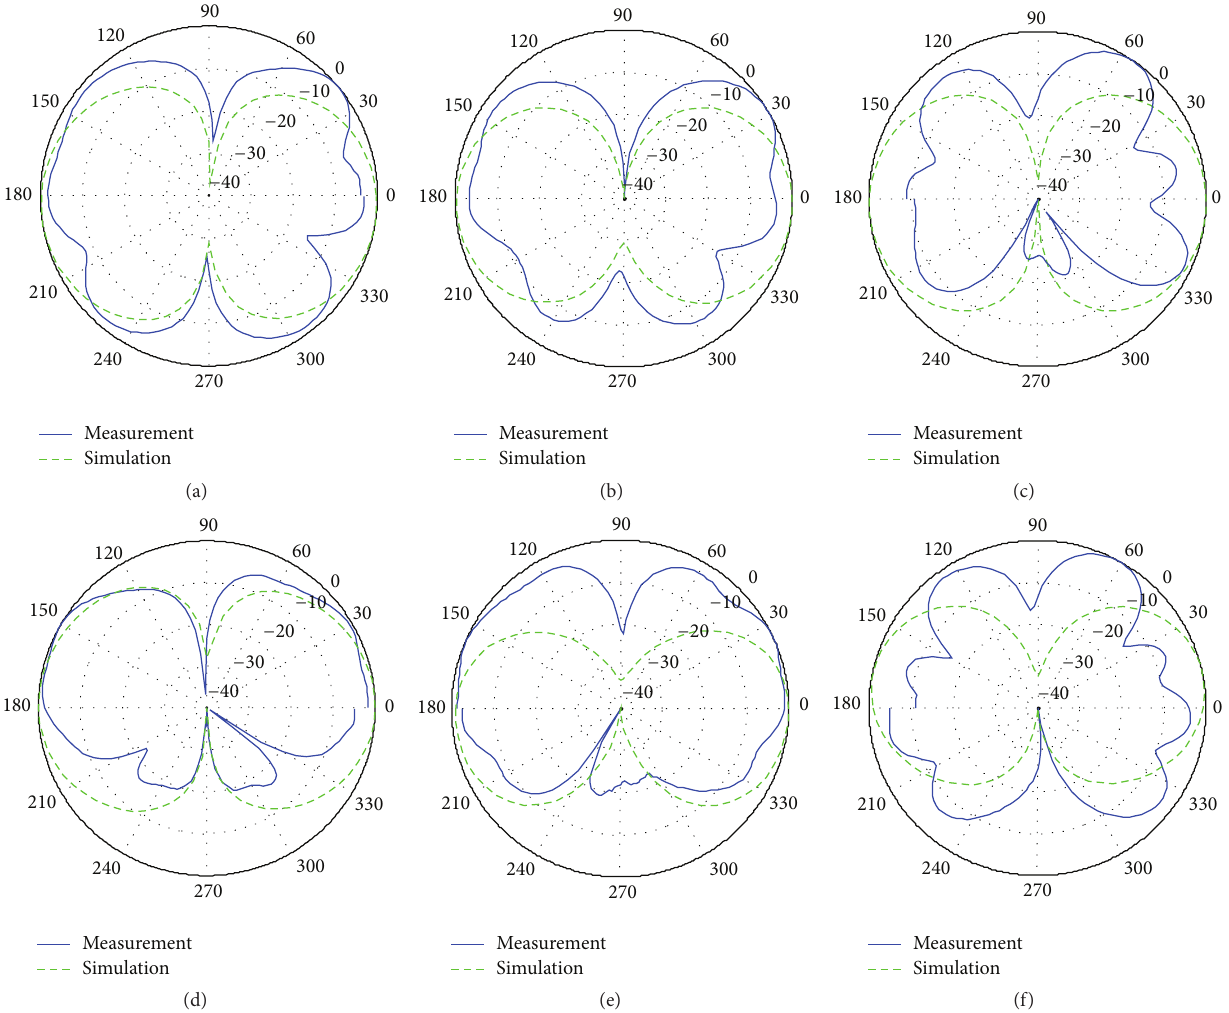
Figure 9: Simulated and measured 𝐸 -plane radiation patterns of (a) CPW-fed slot antenna, (b) cactus antenna, and (c) miniaturized cactus antenna at 5GHz and (d) CPW-fed slot antenna, (e) cactus antenna, and (f) miniaturized cactus antenna at